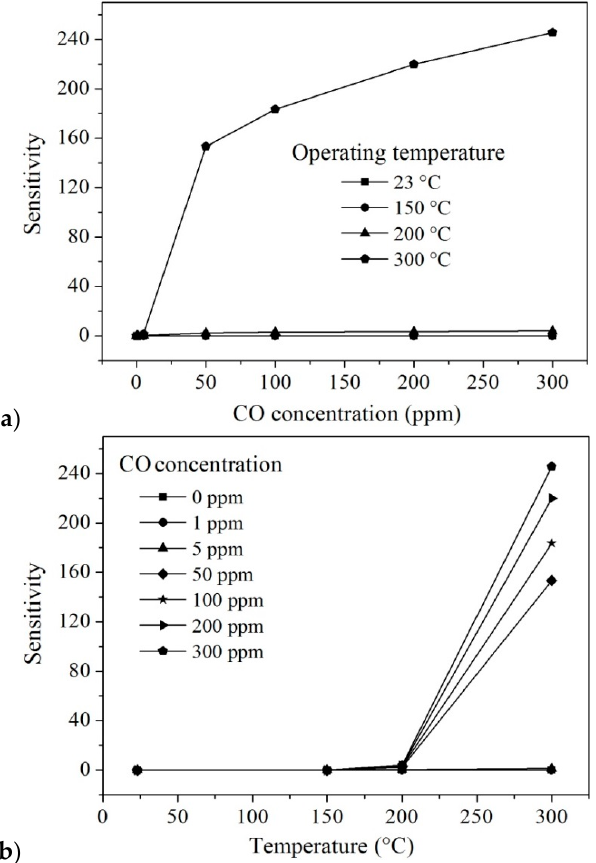
Figure 7. Sensitivity of MgSb 2 O 6 pellets: ( a ) S vs. CO concentration; ( b ) S vs. operating temperature. Table 1. Sensitivity values of MgSb 2 O 6 in CO atmospheres.